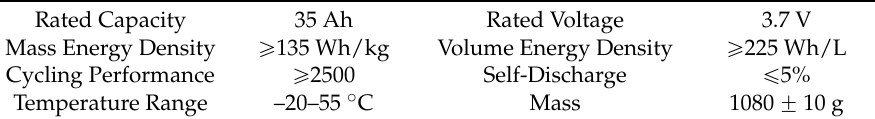
Table 1. Main parameters of the battery cell.